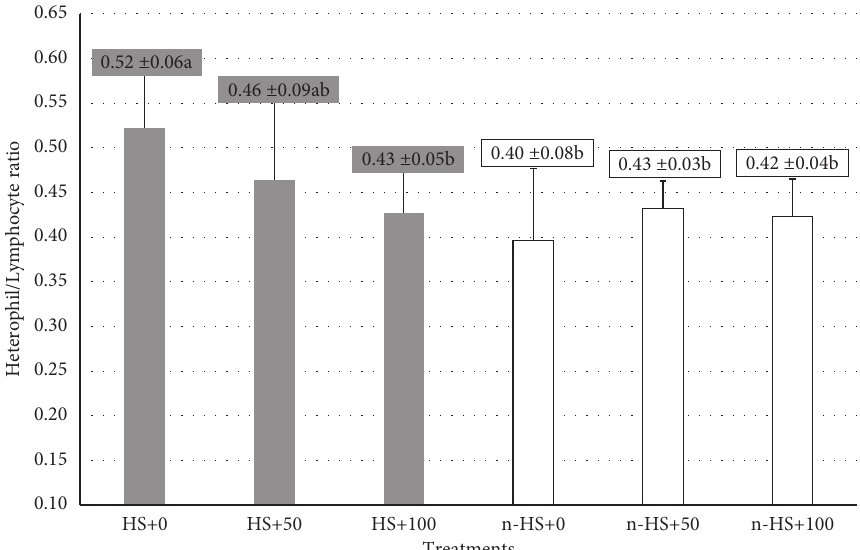
Figure 1: The average values of the heterophile/lymphocyte ratio of chicken blood Salix leaf extract in underexposed and unheated conditions. Different superscript letters on the graph showed significant differences ( P < 0 . 05).